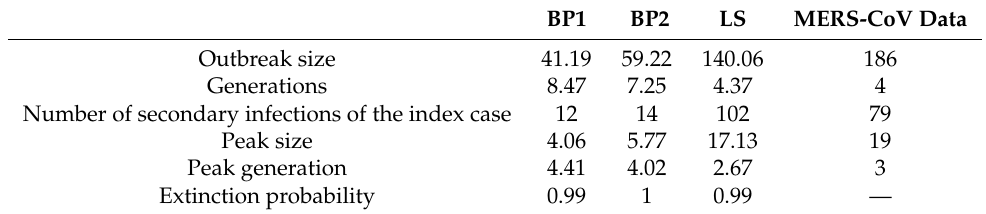
— The right panel of Figure 7 illustrates the results of three models using R 0 = 0.96 and k = 0.063 of the LS model. Blue bars show the frequency of secondary cases of the 2015 MERS-CoV outbreak compared with the results of the three models: BP1 is a green triangle curve, BP2 is a yellow cross curve, and LS is a blue circle curve. The probability of no secondary infection Pr ( Z = 0 ) is compared using the three models: Pr ( Z = 0 ) = 0.38 (BP1), Pr ( Z = 0 ) = 0.51 (BP2), and Pr ( Z = 0 ) = 0.85 (LS), respectively. The LS model captures the secondary cases in the 2015 MERS-CoV outbreak, indicating that the 2015 MERS-CoV outbreak had enormous